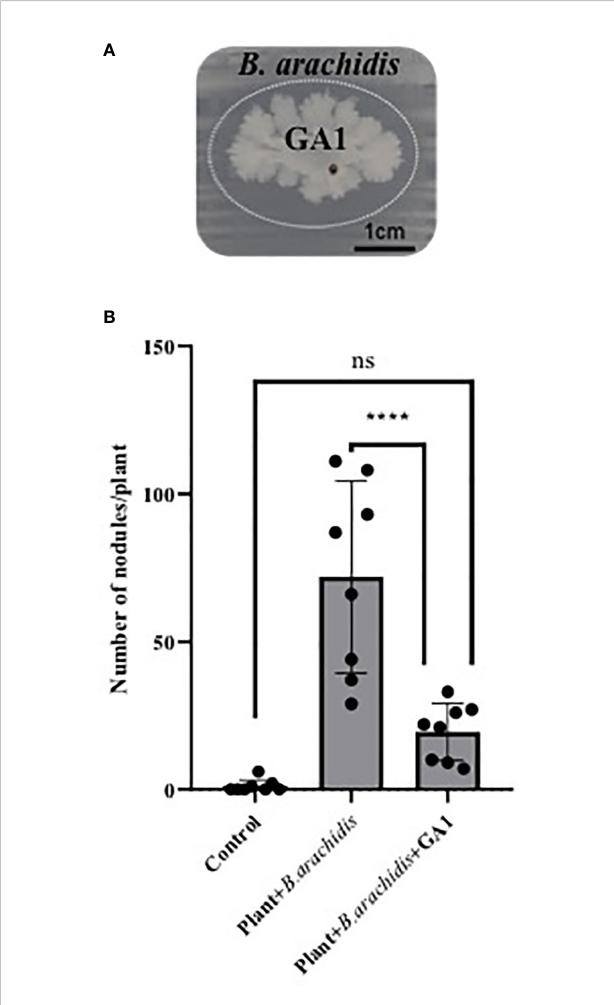
FIGURE 4 (A) Antagonistic effect of Bacillus velezensis GA1 (growing colony at the center) against Bradyrhizobium arachidis (growing as thin layer of cells over the whole surface) on Yeast Extract Mannitol Agar. It is visualized by the inhibition zone delimited by a dotted elliptic line. (B) Impact of Bacillus inoculation on B. arachidis nodulation on roots evaluated based on the number of nodules in each treatment; Plant: non-inoculated plants; Plant + B. arachidis : A. rolfsii infected peanut plants inoculated with B. arachidis Plant + B. arachidis + GA1: A. rolfsii infected peanut plants inoculated with B. arachidis and B. velezensis GA1.Values are the mean ± SD from eight replicates of one experiment. ****,p < 0.0001 and ns (no signi fi cant difference), p >